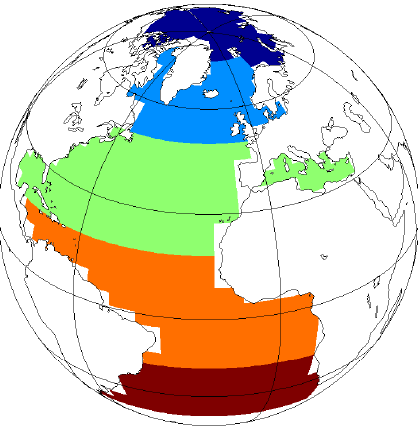
Fig. 1. The 5 RECCAP regions in the Arctic and Atlantic